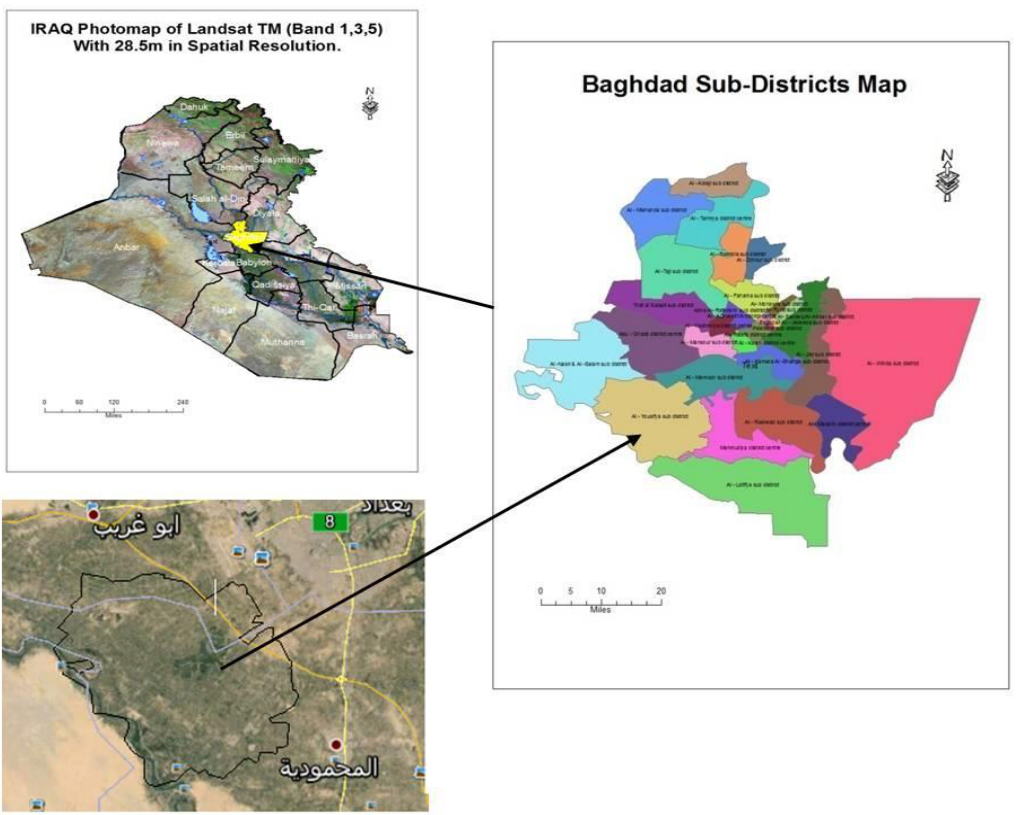
Fig.1: Location of